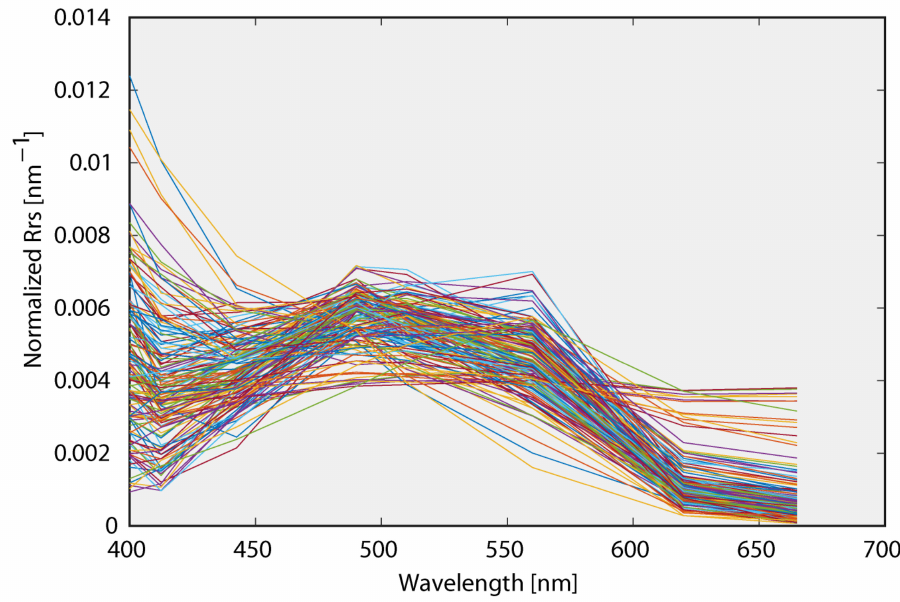
Figure 3. The normalized reflectance spectra ( R rs ) used in this